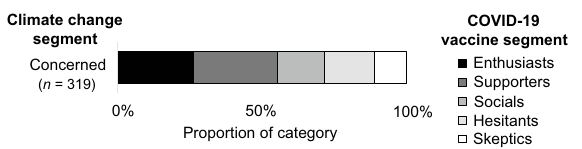
Figure 1. Vaccine segment distributions within the Concerned climate